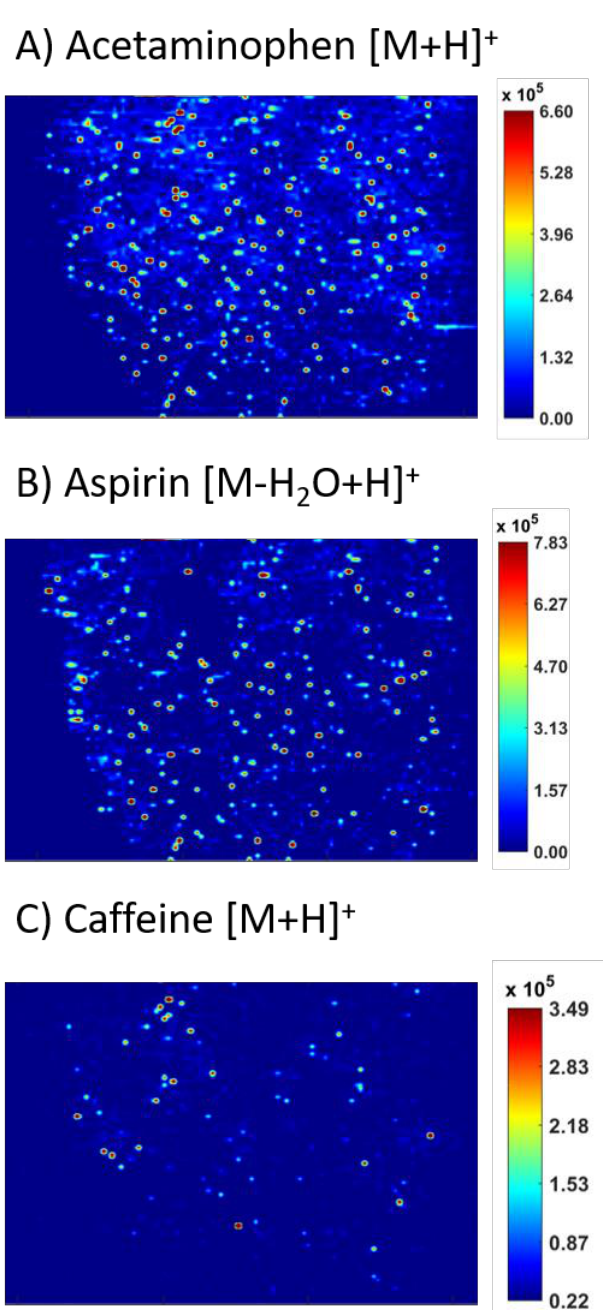
Figure 5. MS images of the three APIs in brand “C” over the counter tablets, including ( A ) ac- Figure 5 . MS images of the three APIs in bra nd “C” over the counter tablets, including ( A ) aceta- minophen, ( B ) aspirin, and ( C ) caffeine. etaminophen, ( B ) aspirin, and ( C )